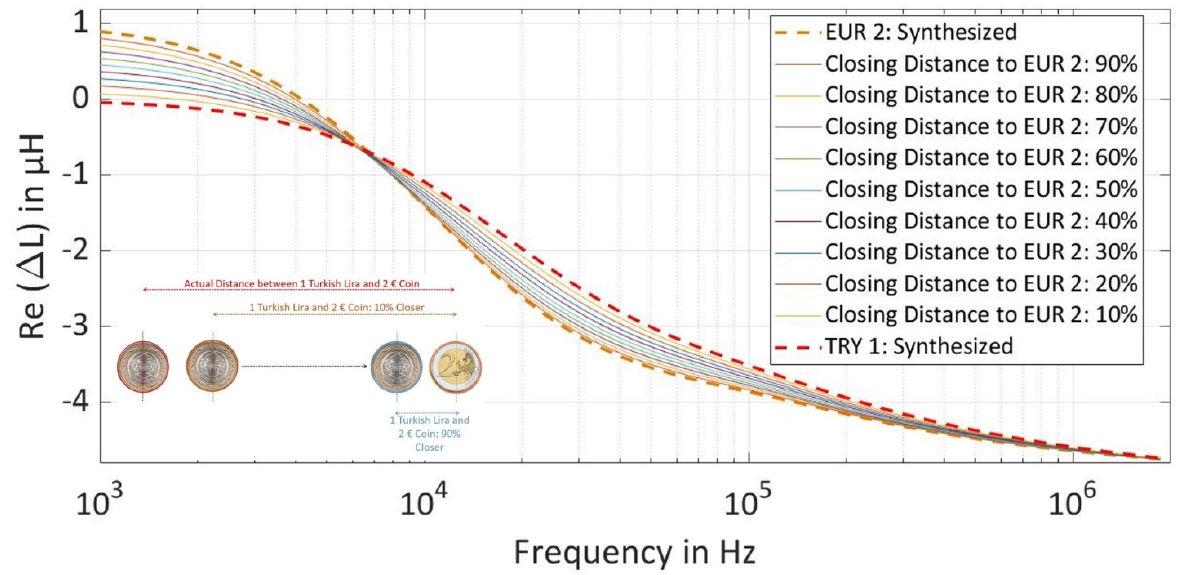
Figure 5. Real Values of Synthesized Intermediate Inductance Spectra at different Difficulty Levels of TRY 1 Coin by Bringing the Parameters of Coin Closer to EUR 2 Coin.